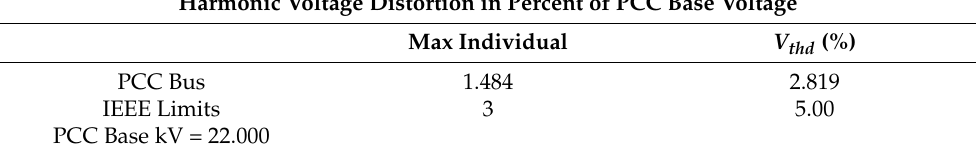
Table 10. ESA calculation results for IEEE Std. 519 current report with